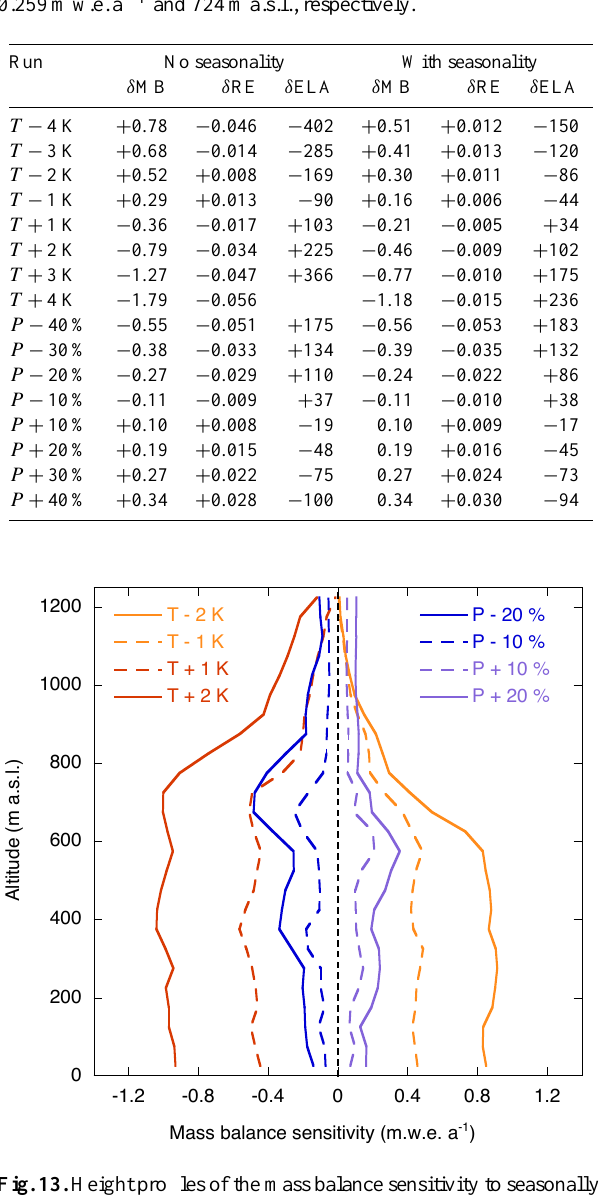
Fig. 13. Height profiles of the mass balance sensitivity to seasonally invariant changes in air temperature T and precipitation P